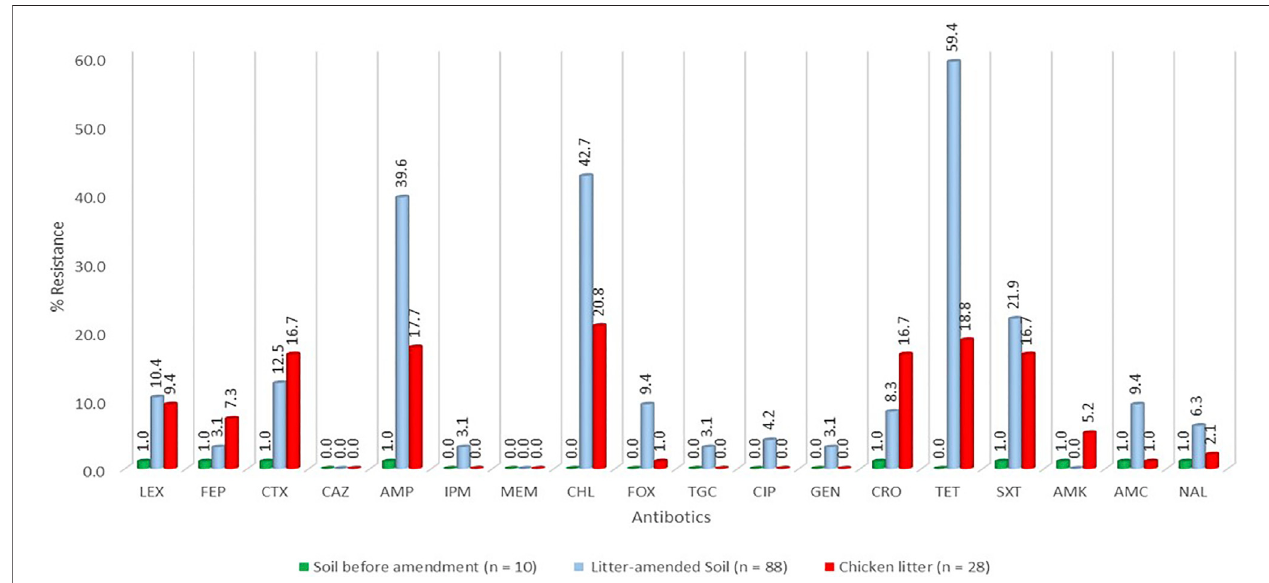
FIGURE 2 | Percentage resistance of the E. coli strati fi ed by sample source. LEX-Cefalexin, FEP-Cefepime, CTX-Cefotaxime, CAZ-Ceftazidime, AMP- Ampicillin, FOX-Cefoxitin, TGC-Tigecycline, CIP-Cipro fl oxacin, TET-Tetracycline, SXT- Trimethoprim-sulfamethoxazole, AMC-Amoxicillin-clavulanic acid, CHL- Chloramphenicol, GEN- Gentamicin, AMK- Amikacin, MEM-Meropenem, CRO-Ceftriaxone, IPM-Imipenem, NAL-Nalidixic acid.